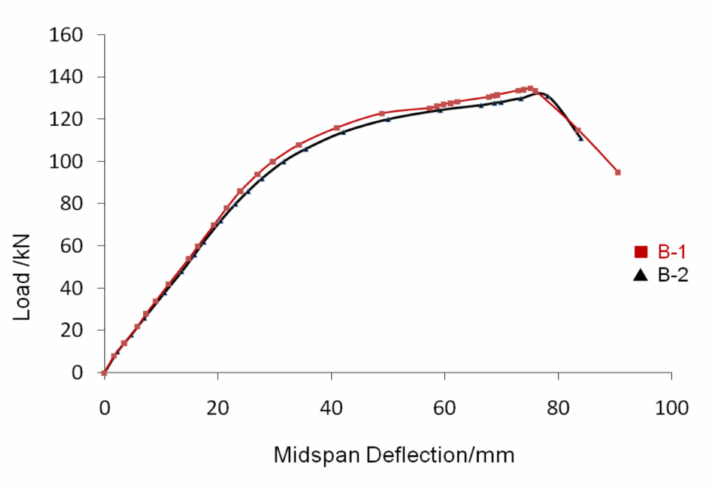
Figure 7. Load-deflection relationship of tests B-1 and